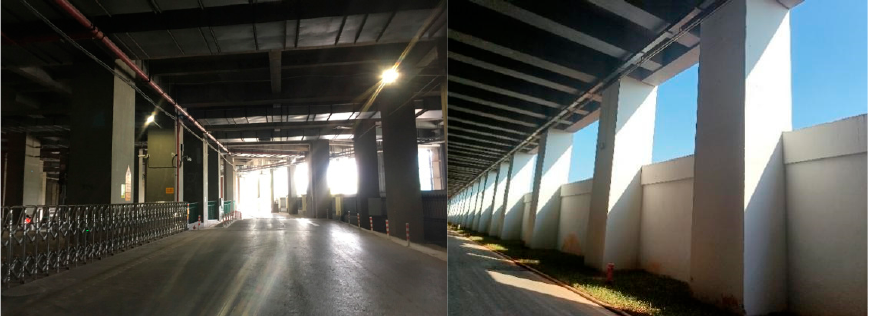
Figure 2. Covering the opening of new green recyclable fireproof insulation board.